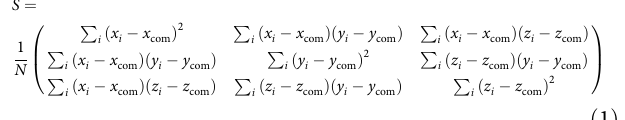
Fig. 7 A plot of the rescaled histogram of the low-concentration image stack (blue bars) and the rescaled number (normalized) of clusters detected as a function of the binarization threshold (green dots). The red dashed line shows the grayscale intensity bins that yield the largest number of clusters. Thresholds greater or less than these thresholds create artifacts in the solution owing to background noise. The accuracy in identifying the binarization threshold is highly dependent on the contrast of the images. The horizontal axis shows the grayscale intensity values. Both the histogram and the number of clusters have been normalized to their maximum value to permit comparison of peak locations. Figure 8 is a representative example of the results after applying the thresholds identi fi ed by either of the two bins. Figure 8a shows the tomographic slice 42 of Supplementary Fig. 3 (as an example) of the low-concentration sample. The dark tone (i.e., high electron density) of the corona makes it distin- guishable from the background noise. Figure 8b shows the slice after applying the calculated threshold with the clusters of BC in white. Since the NPs also have a dark tone, the same threshold can be applied to identify them.